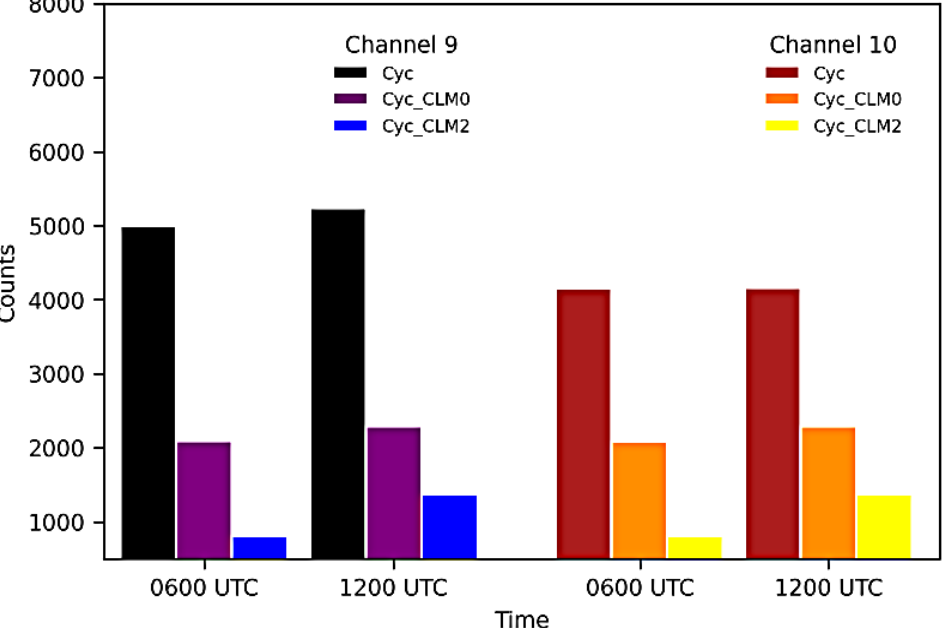
Figure 6. The counts of observations for AGRI channels 9 – 10 from the Cyc, Cyc_CLM0, and Cyc_CLM2 experiments, valid at 0600 UTC 23 July 2021 and 1200 UTC 23 July 2021.